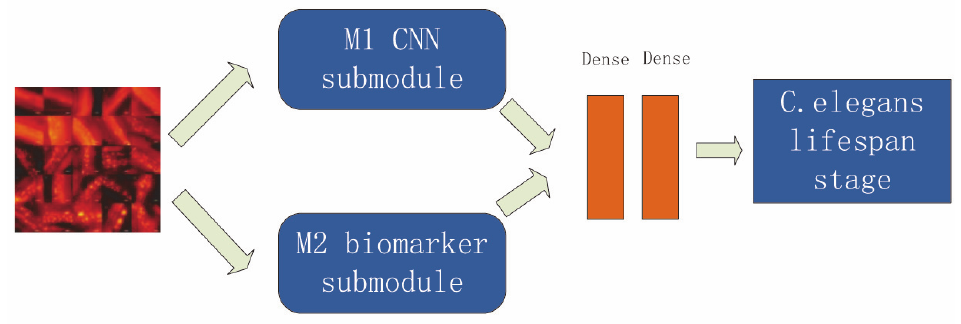
Figure 5. Overall framework for the CNN dual ‐ path feature fusion model.